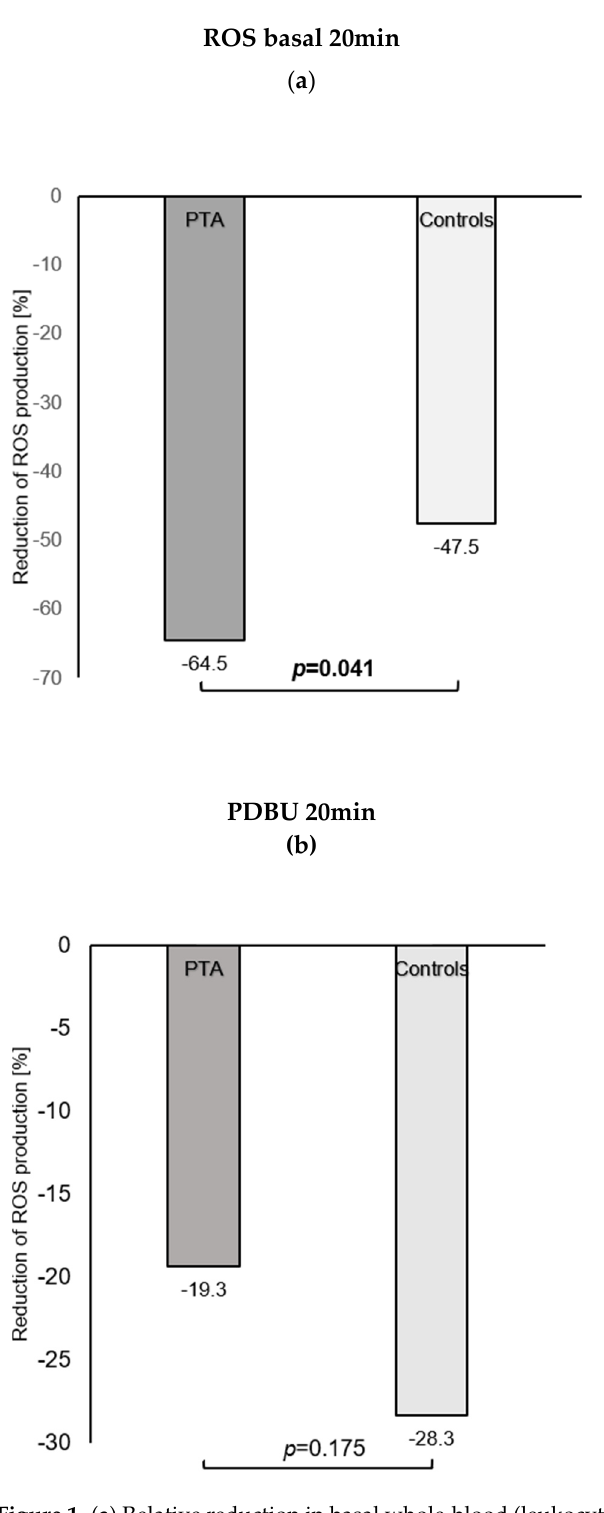
Figure 1. ( a ) Relative reduction in basal whole-blood (leukocyte) ROS production as % of the value at admission in the 2 treatment groups after 3 months. Data are presented as mean values. ( b )